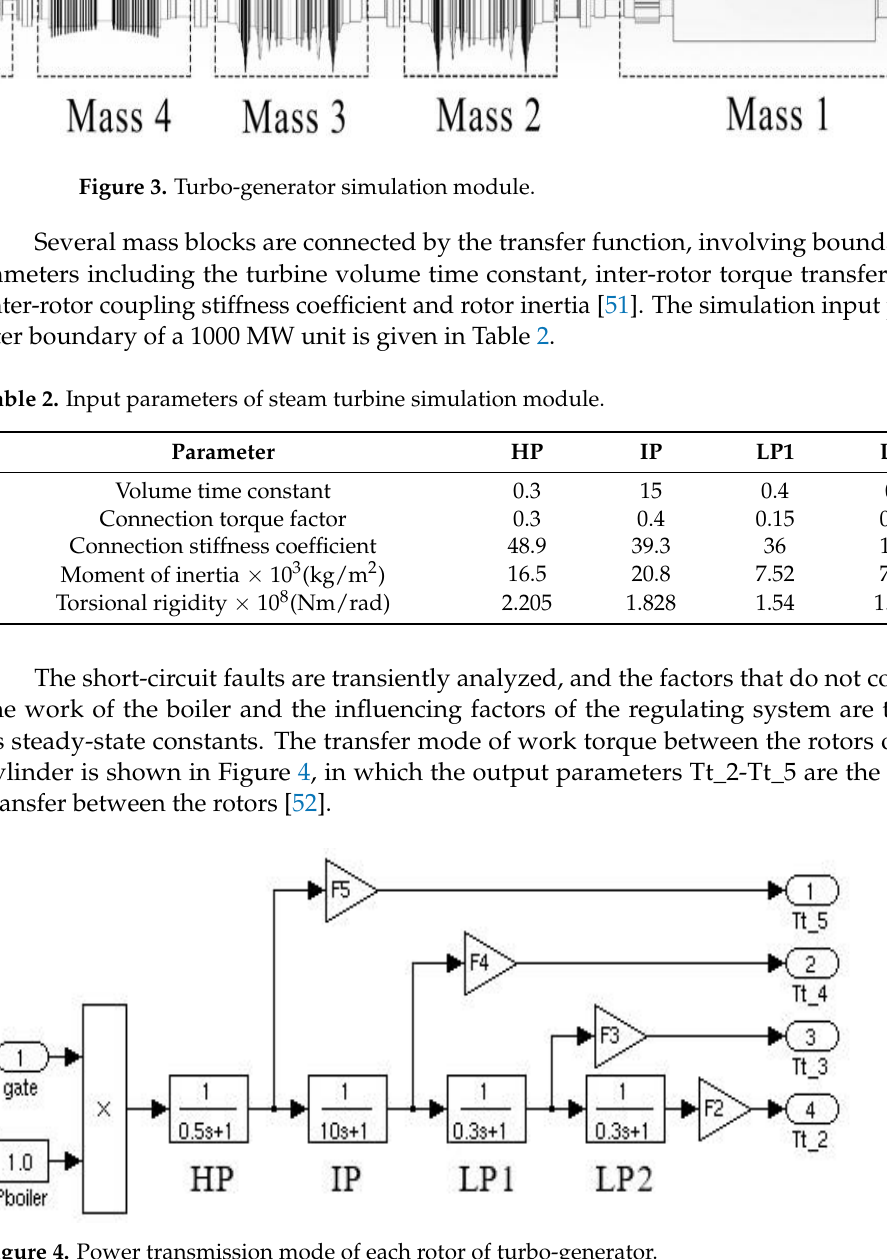
Figure 4. Power transmission mode of each rotor of turbo-generator.